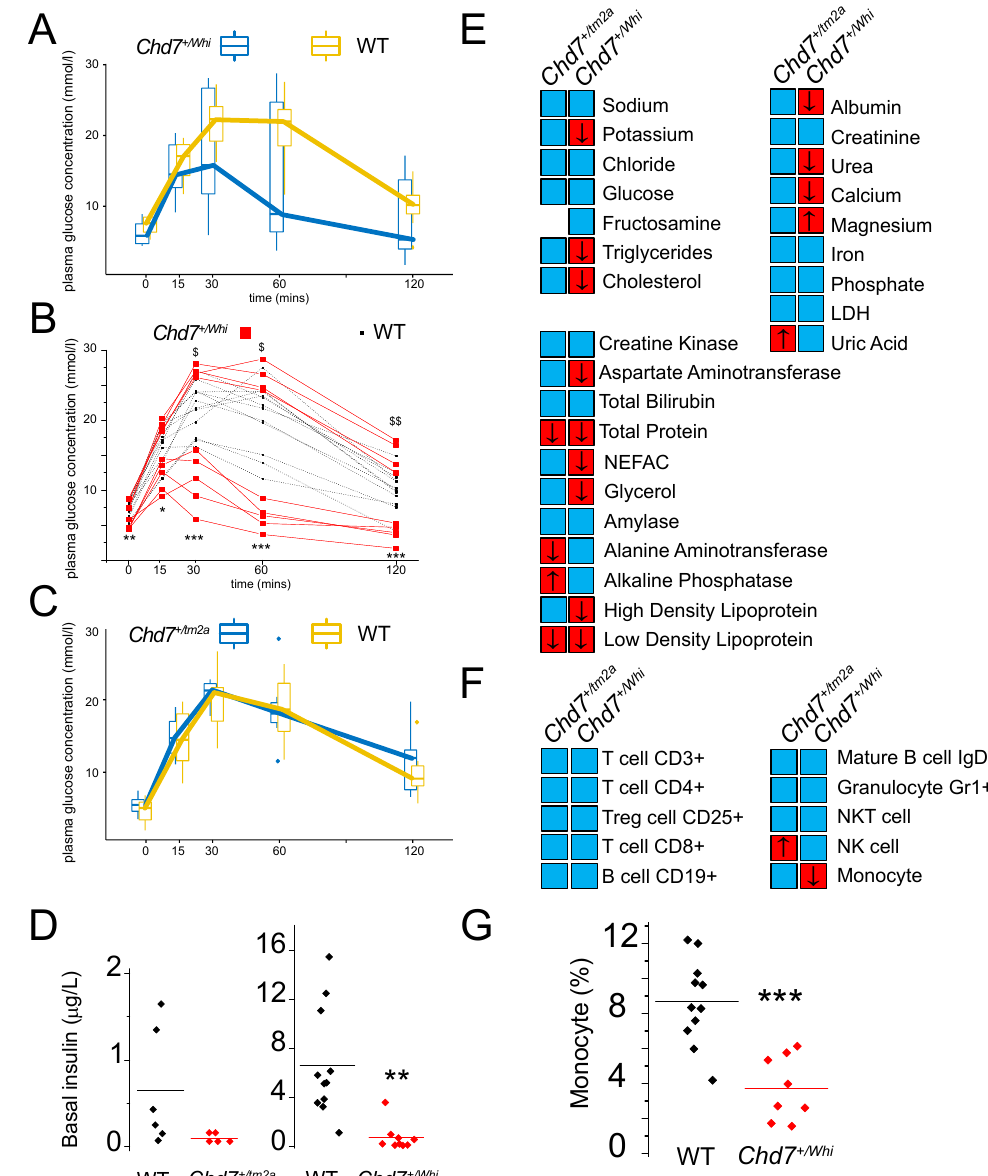
Figure 4. Metabolic and immunological parameters show dichotomic features between Chd7 +/tm2a and Chd7 +/Whi mutants. ( A ) Glucose tolerance expressed as mean ± sem (boxes) with outliers (whiskers) in Chd7 +/Whi mice. ( B ) When the data are plotted as individuals, glucose tolerance in Chd7 +/Whi mice show binomial distribution: two groups (high responders and low responders) can be identified. $ p < 0.05 and $$ p < 0.005 relative to controls in the high responder group. * p < 0.05, ** p < 0.005, *** p < 0.0005 relative to controls in the low responder group using anova repeated measures. ( C ) Box plots representing mean ± sem (boxes) with outliers (whiskers) in Chd7 +/tm2a show normal glucose tolerance relative to their respective controls. ( D ) Basal insulin levels in Chd7 +/tm2a and Chd7 +/Whi mice. ( E ) Blood chemistry summary using a heatmap coded with blue (normal) and red (abnormal) and directionality (arrow going up for increased and down for decreased). Mean ± sem and t-test statistics are available in Supplementary Table S5. ( F ) Immunology screen summary illustrated using a heatmap and based on results available in Supplementary Table S6. Colour coded as in ( E ): blue (normal) and red (abnormal) and directionality (arrow going up for increased and down for decreased). ( G ) Monocyte mean and individual points for Chd7 +/Whi mice. Statistics based on t-tests unless otherwise